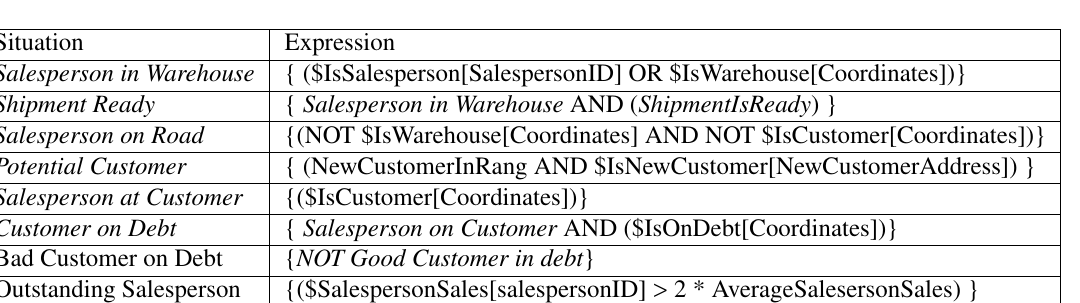
Table 2. Context